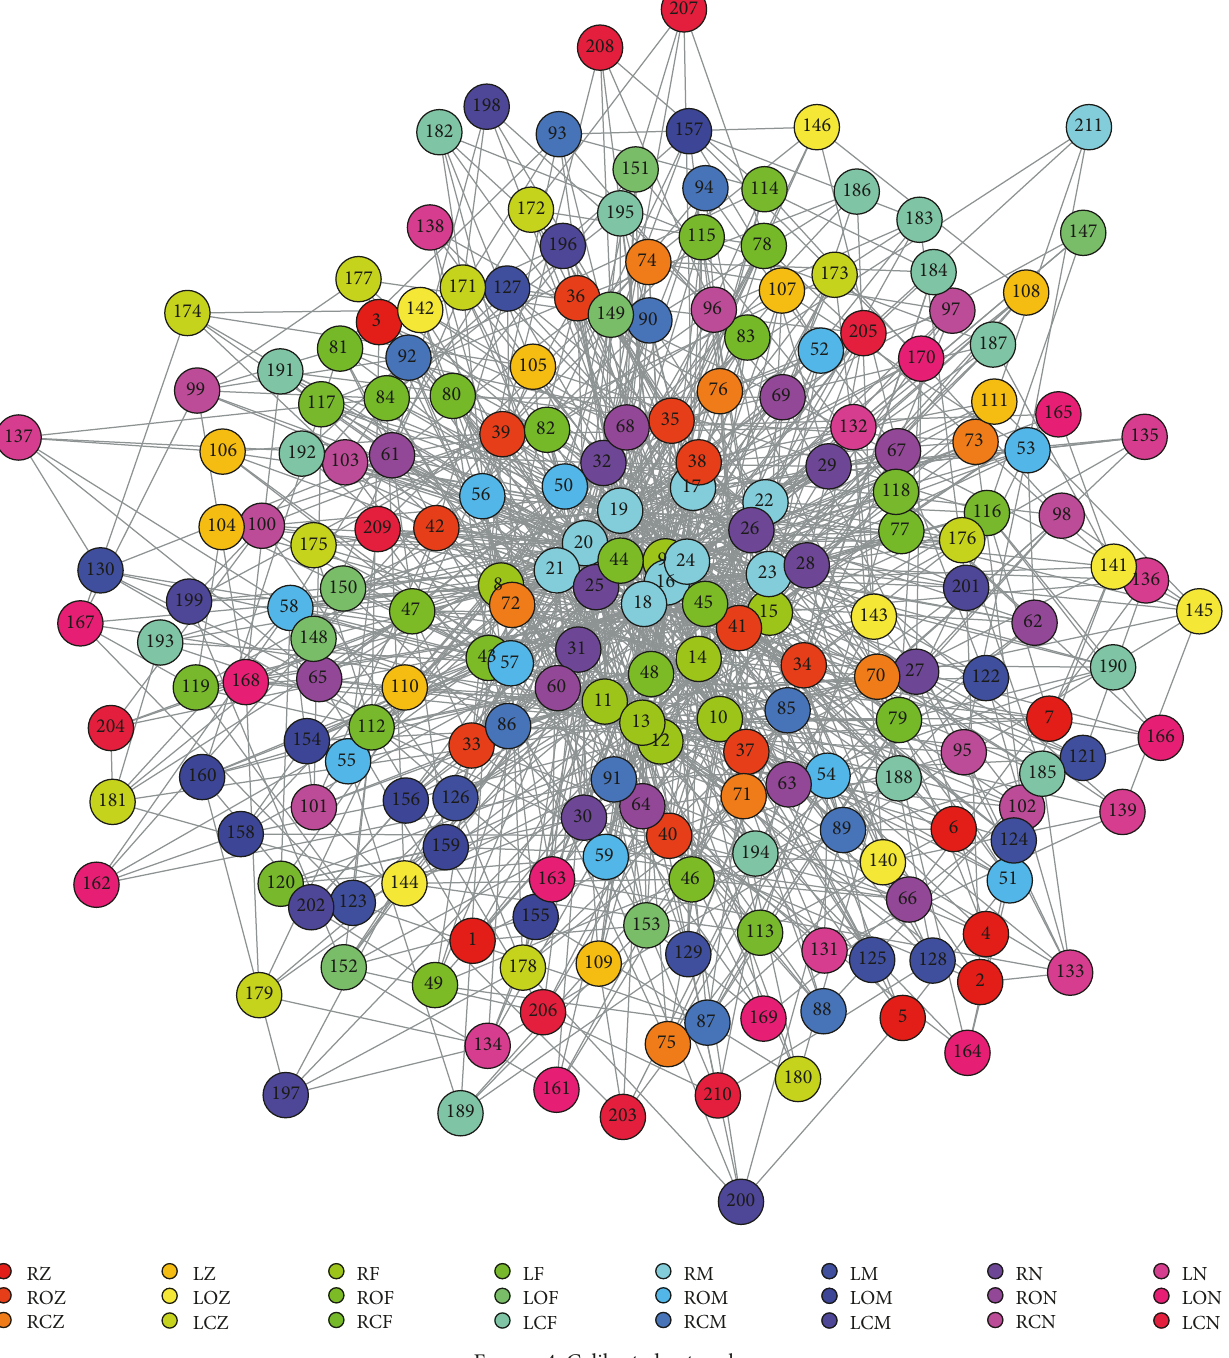
Figure 4: Calibrated